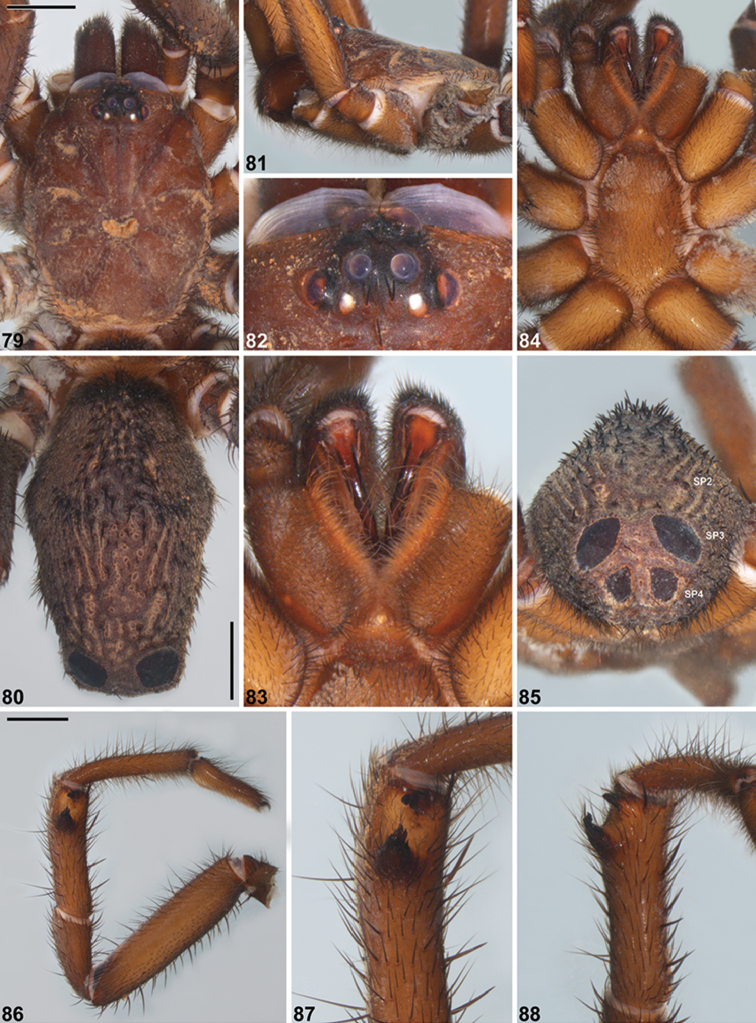

Idiosoma
clypeatum sp. n., male holotype (WAM T96452) from Albion Downs (Western Australia; MUR), somatic morphology. 79–80 Carapace and abdomen, dorsal view 81 Carapace, lateral view 82 Eyes, dorsal view 83 Mouthparts, ventral view 84 Sternum, ventral view 85 Abdomen, posterior view 86 Leg I, prolateral view 87 Leg I tibia, clasping spurs, prolateral view 88 Leg I tibia, proventral view. Scale bars 2.0. SP2–4 = sigilla pairs 2–4.